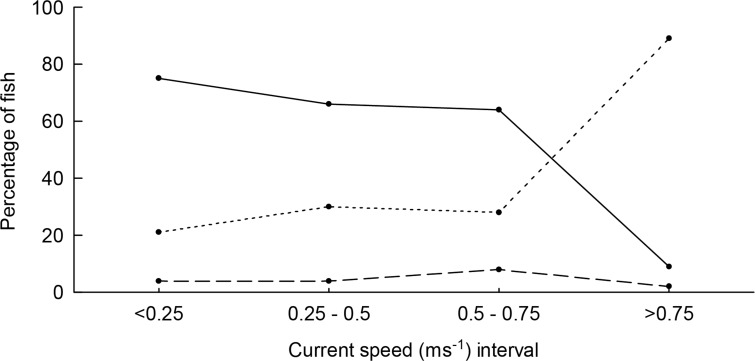
Observed swimming direction for pelagic associated fish over categories of current speed.Solid line indicates counter-current swimming; dotted line indicates along-current swimming; broken line denotes transverse swimming. The results indicate that in strong currents most fish swim along with the flow.